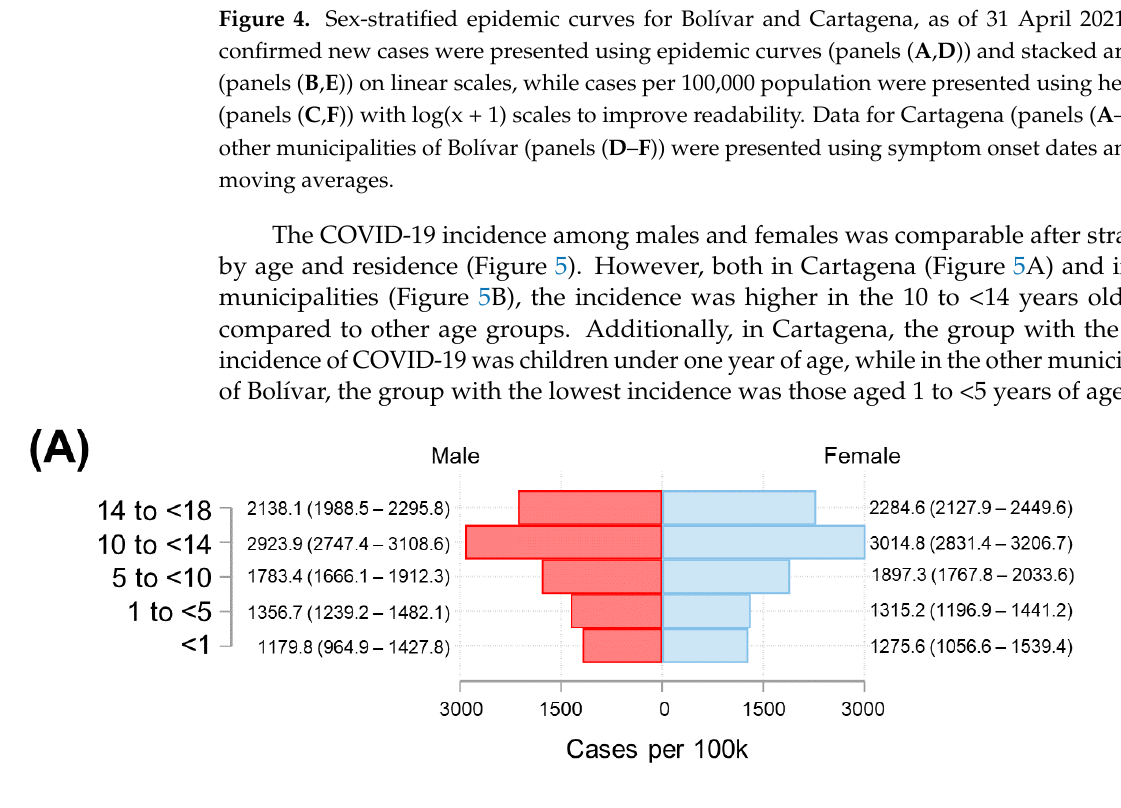
Figure 4. Sex-stratified epidemic curves for Bol í var and Cartagena, as of 31 April 2021. Daily confirmed new cases were presented using epidemic curves (panels ( A , D )) and stacked area plots (panels ( B , E )) on linear scales, while cases per 100,000 population were presented using heat maps (panels ( C , F )) with log(x + 1) scales to improve readability. Data for Cartagena (panels ( A – C )) and other municipalities of Bol í var (panels ( D – F )) were presented using symptom onset dates and 7-day moving averages.